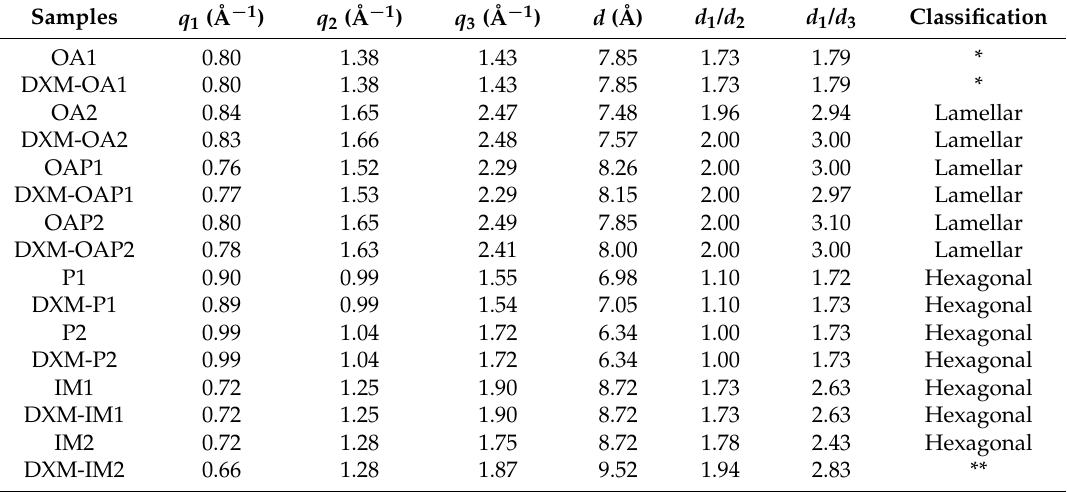
Table 2. Peak positions ( q ) of the small-angle X-ray scattering (SAXS) curves, their respective correlation distances ( d ), and assignments for phase classification ( d 1 / d 2 , d 1 / d 3 ). DXM stands for dexamethasone loaded formulations. The sample compositions are described in Table